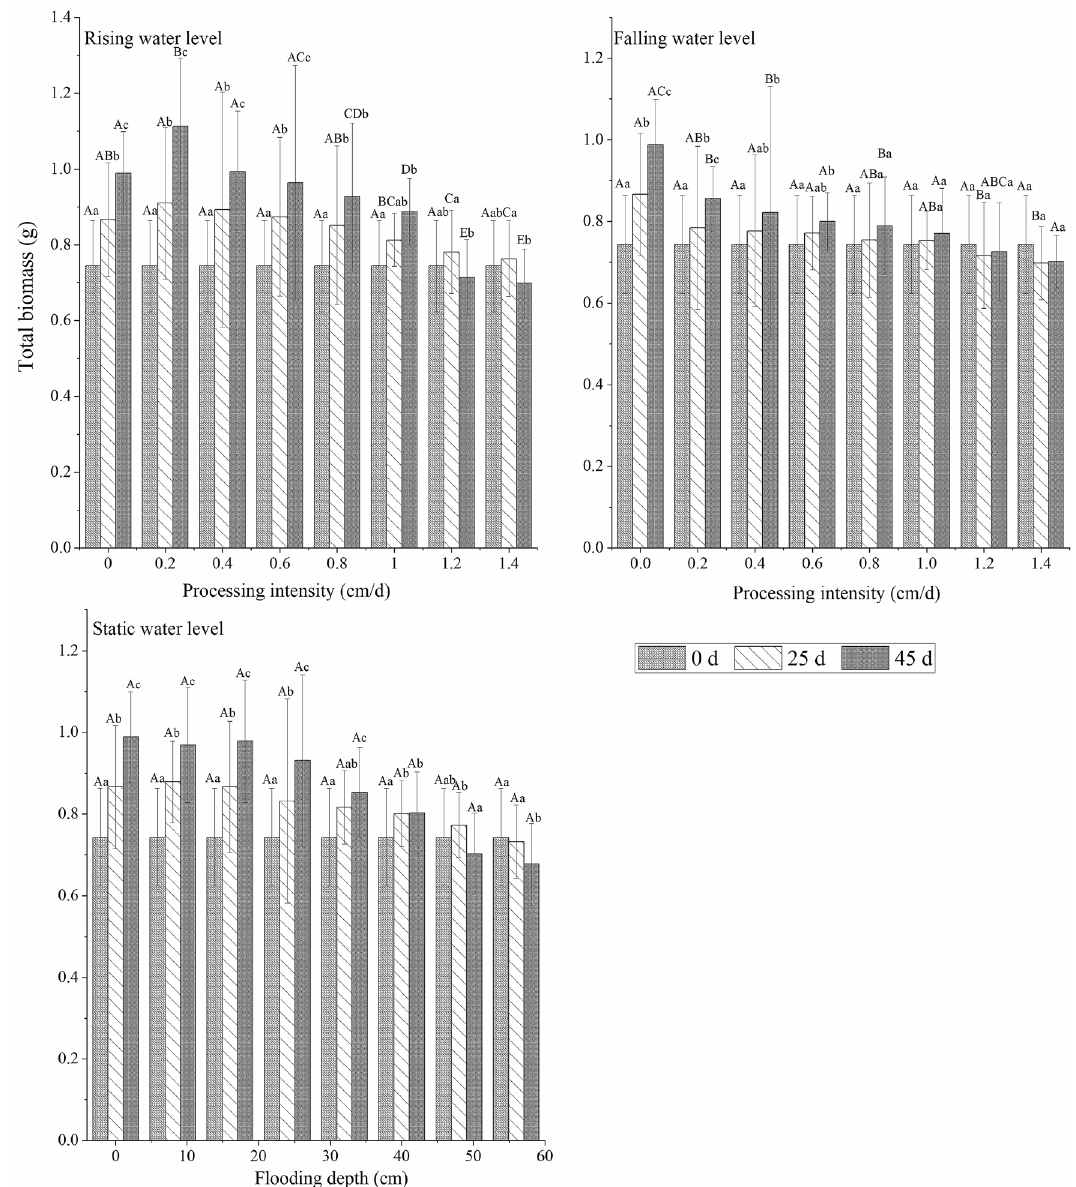
Figure 2. Effects of different hydrological environments on the total biomass and bioavailability of C.